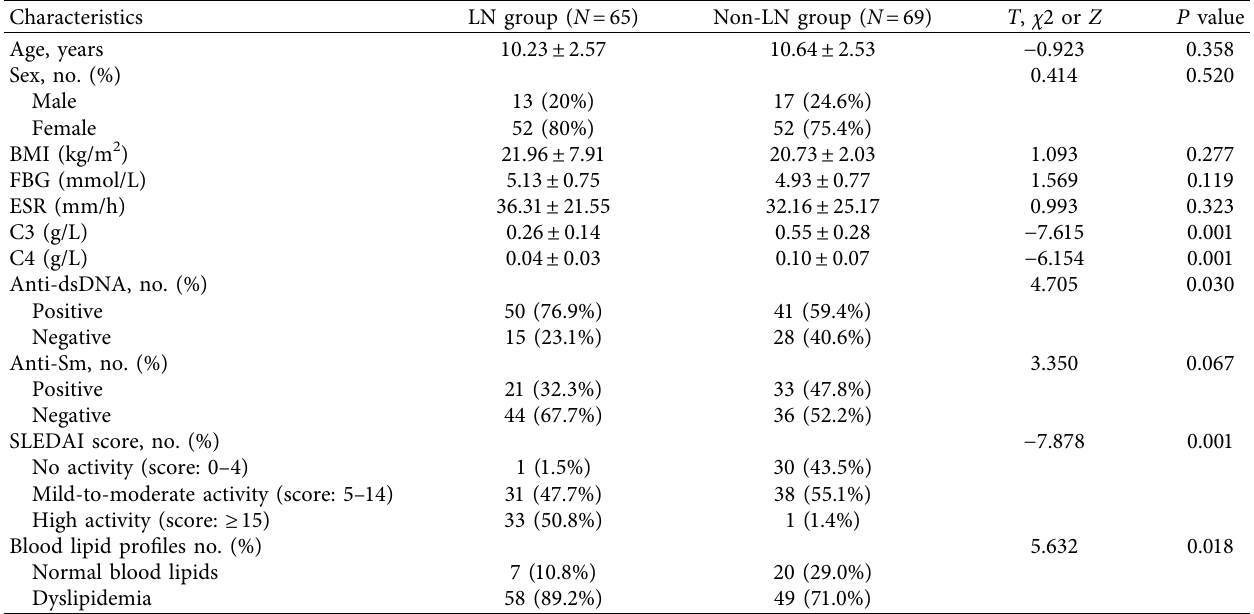
Table 1: Characteristics of the enrolled